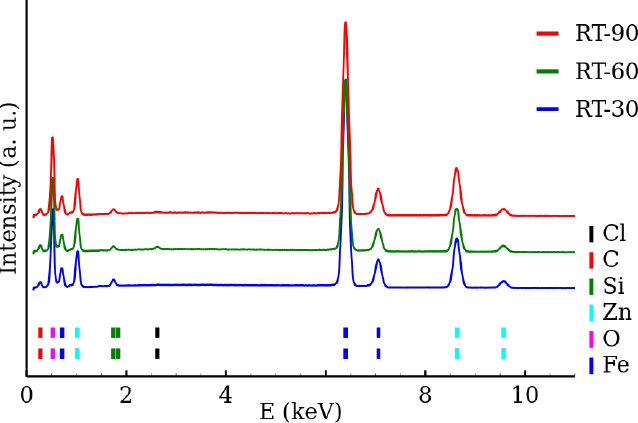
Figure 5. EDS spectra of room temperature synthesized zinc ferrite nanoparticles.